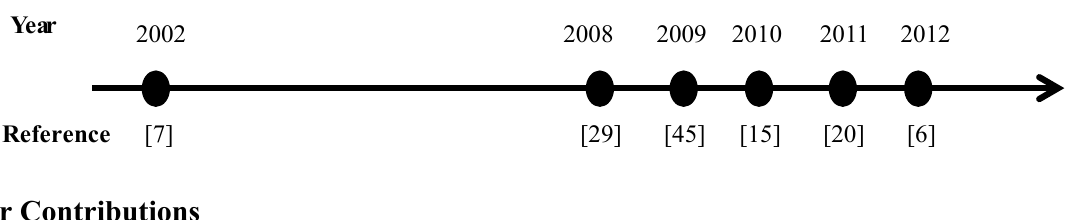
Figure 1. Synoptic roadmap of the landmark reviewed